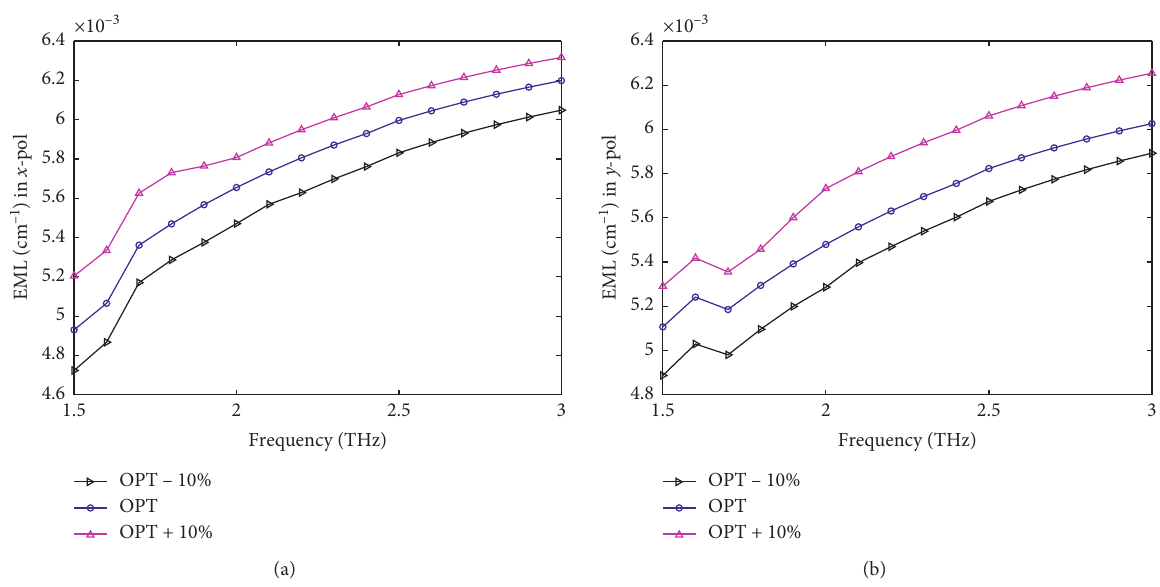
Figure 5: Comparison of the EML for the three models as a function of the THz band. (a) x -PoM and (b) y -PoM.